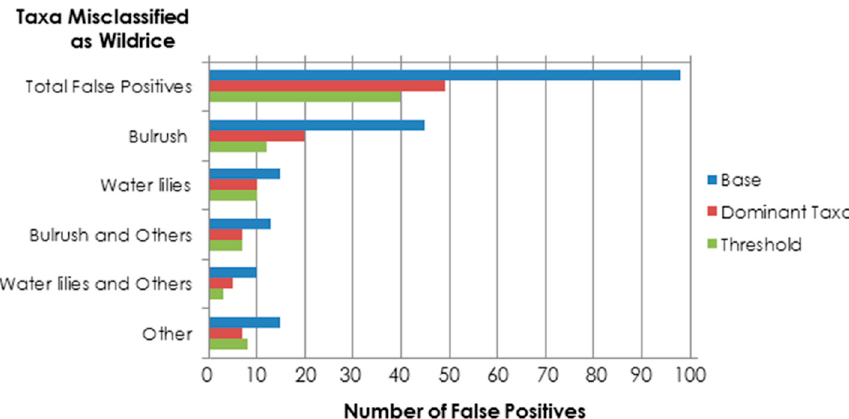
Figure 9. The number of absence samples misclassified as wildrice from each taxon for each model modification when applied to its corresponding validation set (i.e., base model applied on base validation dataset, etc.). General proportions of misclassification are preserved when validated on noncorresponding validation sets (i.e., base model applied to threshold validation dataset, etc.) (Appendix A Table A2). Vegetation absence points included for the base, dominant taxa, and threshold models were 422, 333, and 300